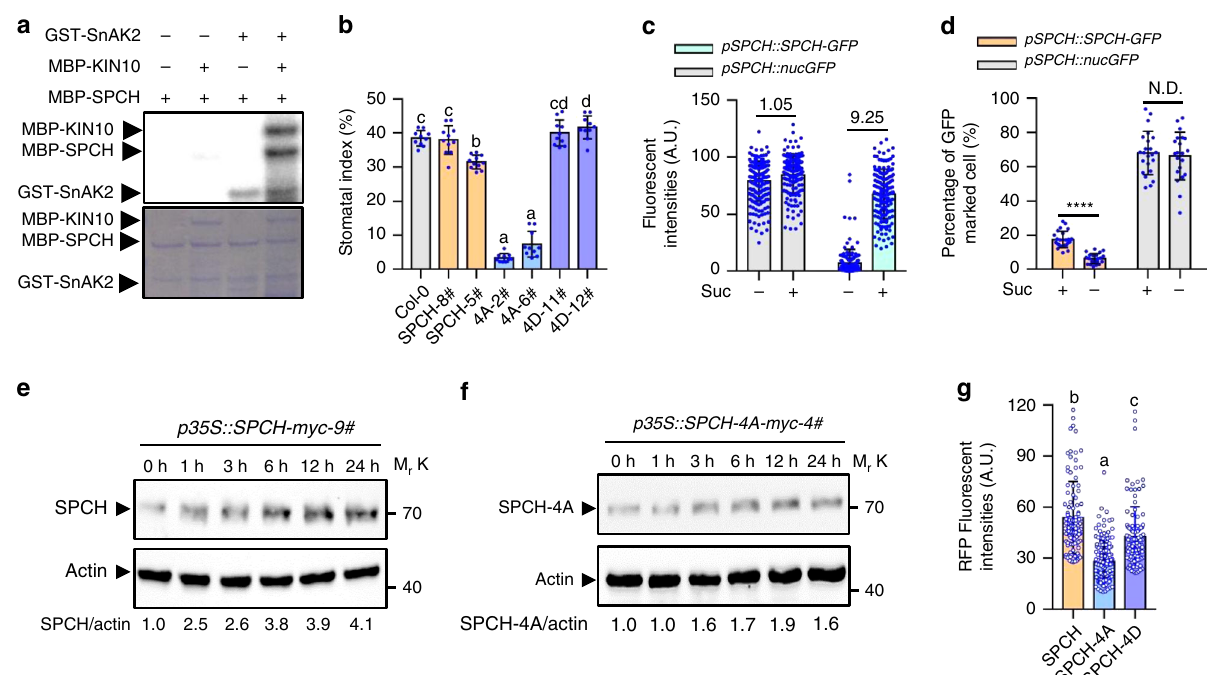
Fig. 5 KIN10 phosphorylates and stabilizes SPCH to promote stomatal development. a Phosphorylation of SPCH by KIN10-MBP in vitro. Upper lines showed the gel image of ATP- γ -p32 labeled protein and bottom lines showed the gel image of Coomassie brilliant blue staining. b Quanti fi cation of stomatal index in wild-type plants, and different SPCH complemented transgenic plants. Seedlings of wild-type plants, pSPCH::SPCH-RFP/spch-4, pSPCH:: SPCH-4A-RFP/spch-4 and pSPCH::SPCH-4D-RFP/spch-4 transgenic plants were grown in ½ MS liquid medium with 1% sucrose for 10 days under long-day condition. Error bars indicate standard deviation (S.D.) ( n = 10). c Sucrose increased the protein stability of SPCH. Seedlins of pSPCH::SPCH-GFP and